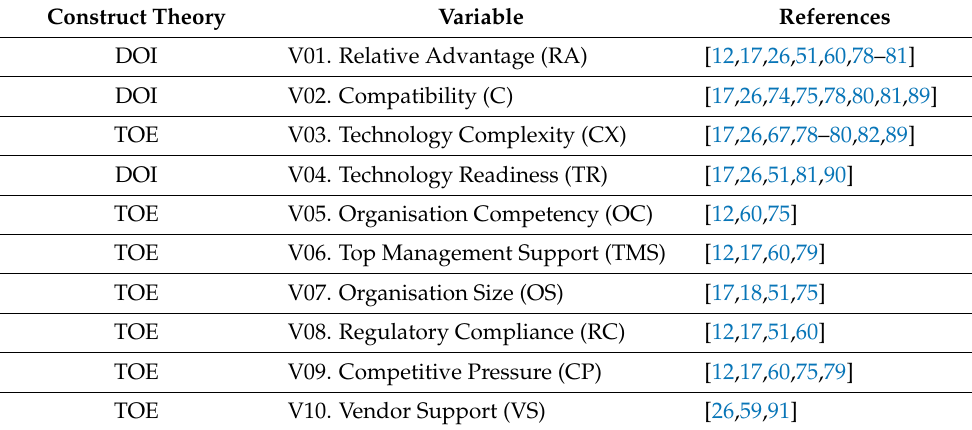
Table 4. Theories and